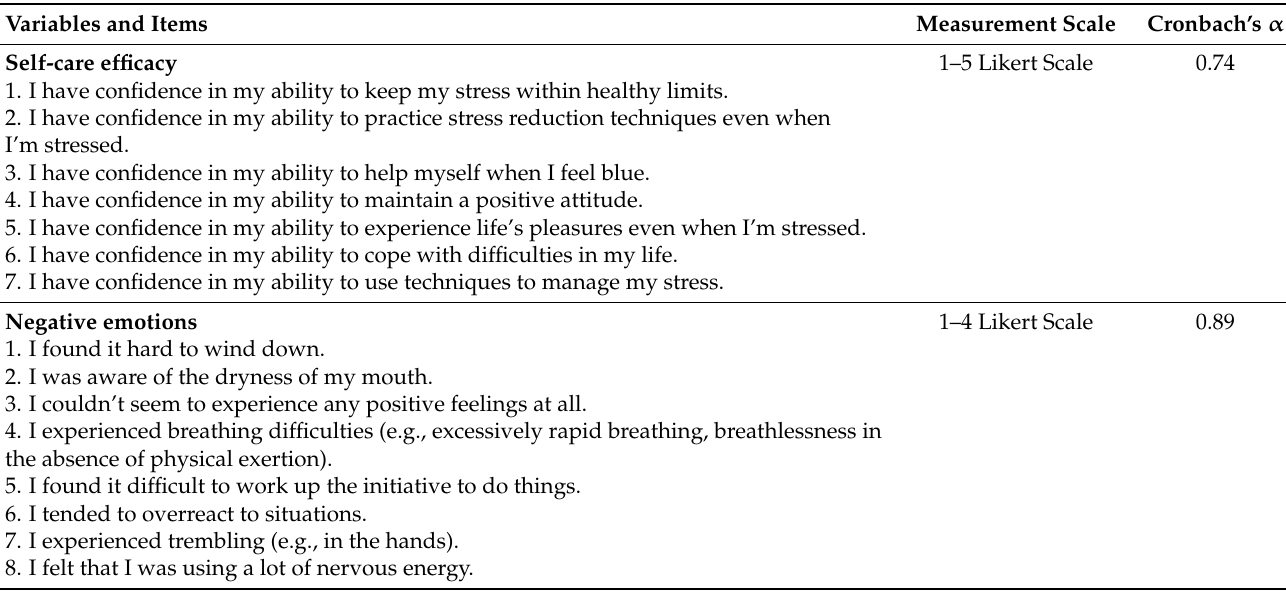
Table A1. Measurements for key